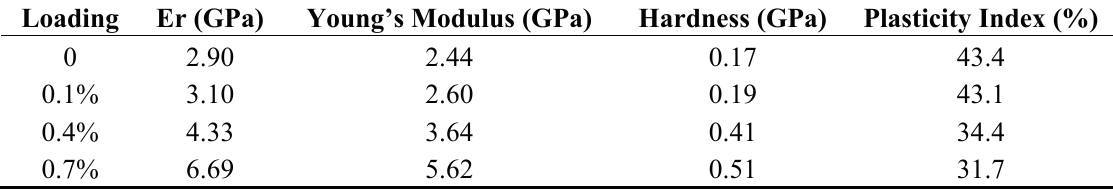
Table 1. Mechanical properties of GNS-based epoxy resin